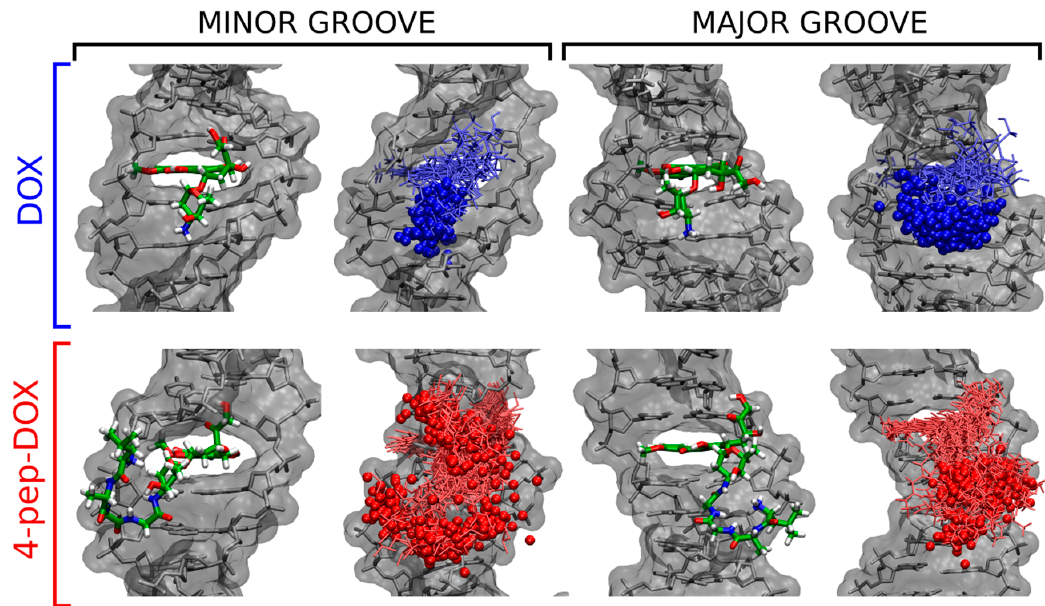
Figure 11. The most likely structures ( left ) and the range of ligand fluctuations ( right ) in the two considered intercalation modes (minor/major groove) of the DOX … dsDNA and 4-pep–DOX … dsDNA complexes. In addition, 100 overlaid representative positions of the protonated amino group (in the amino sugar of DOX or at the N-terminus of the tetrapeptide of 4-pep–DOX) are marked with spheres. In contrast to the DOX case, the most likely arrangement of 4-pep–DOX intercalated into dsDNA from the minor groove accounts for only 35% of the ensemble (Figure 11). In this position, the tetrapeptide fragment resides outside the minor groove, not interacting specifically with the dsDNA chain despite a relatively small average distance to the closest phosphate group (0.76 nm). Notably, DOX and 4-pep–DOX intercalated via the minor groove differ substantially in the orientation of their planar chromophore relative to the flanking base pairs. In particular, the 4-pep–DOX core is rotated by 33° resulting in a decreased stacking overlap with the flanking nucleobases, as compared to DOX (see Figure S3, Supplementary Materials). In its more stable major-groove intercalation mode, 4-pep–DOX exhibits one well-defined structure (74% of the ensemble, Figure 11), in which the tetrapeptide interacts largely with one dsDNA strand, with the mean distance of the amino group to the closest phosphate equal to 0.45 nm. This suggests that effective stabilization of the intercalation complex requires accommodation of the flexible peptide substituent in the wider and more accessible major groove. 3. Materials and Methods 3.1. Materials Fmoc–Leu–Ala–Gly–Gly and Fmoc–Gly–Pro–Leu–Gly–Leu–Ala–Gly–Gly peptides were purchased from Lipopharm.pl (Zblewo, Poland). Oligonucleotides 5 ′ -CGT ACG CGT ACG CGT ACG CG-3 ′ and 5 ′ -CGC GTA CGC GTA CGC GTA CG-3 ′ were purchased from Future Synthesis (Pozna ń , Poland). Collagenase IV and Hank’s Balanced Salt Solution (HBSS), with calcium and magnesium, were purchased from ThermoFisher Scientific (Walthman, MA, USA). Acetonitrile (ACN), 4-aminophenylmercuric acetate (APMA), dichloromethane (DCM), 2,5-dihydroxybenzoic acid (DHB), N,N-dimethylformamide (DMF), doxorubicin hydrochloride, formic acid, isobutyl chloroformate, methanol, sodium hydroxide, tetrahydrofuran (THF), triethylamine (TEA), and Tris- HCl were purchased from Sigma-Aldrich (St. Louis, MO, USA). Column chromatography was performed using silica gel NORMASIL 60 (40–63 mesh, VWR Chemicals, Radnor, PA, USA). Thin-